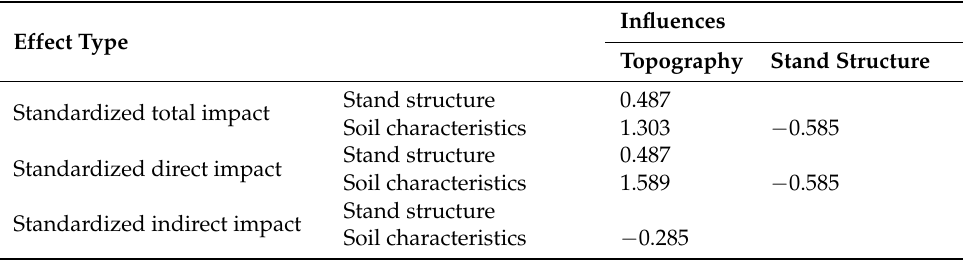
Table 4. Standardized influence coefficients of latent variables in the structural equation model of Robinia pseudoacacia and Pinus tabulaeformis mixed plantations in the Caijiachuan